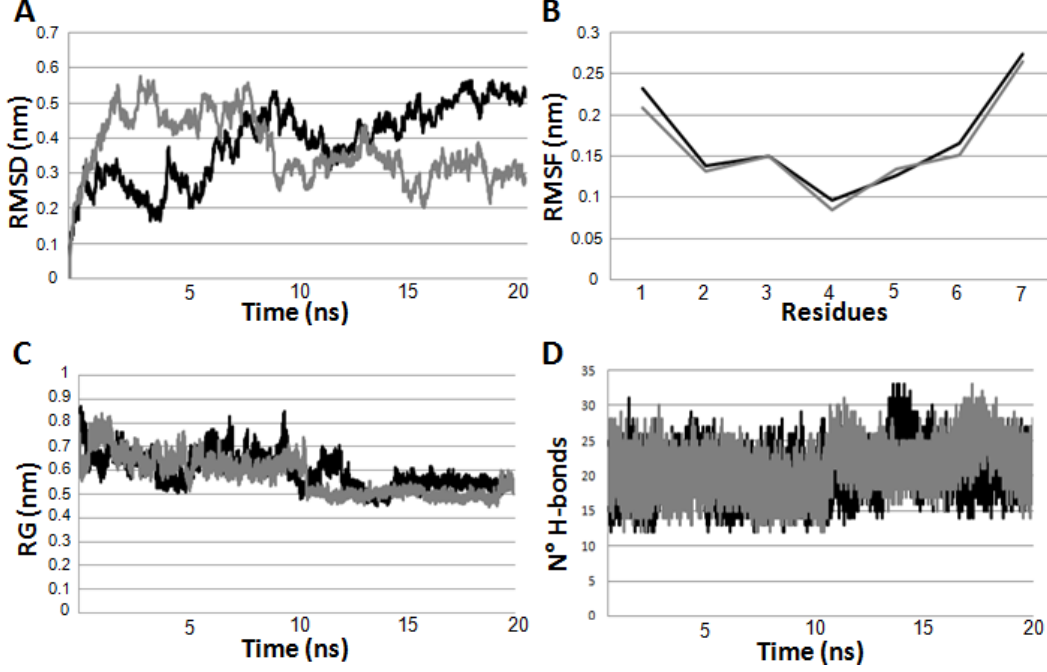
Figure 4. Analysis of the molecular dynamics simulations performed on PepE (in black) and PepK (in grey) at physiological pH in explicit solvent in terms of: ( A ) root mean square deviation (RMSD) plot; ( B ) root mean square fluctuation (RMSF); ( C ) gyration radius plot; and ( D ) H-bonds